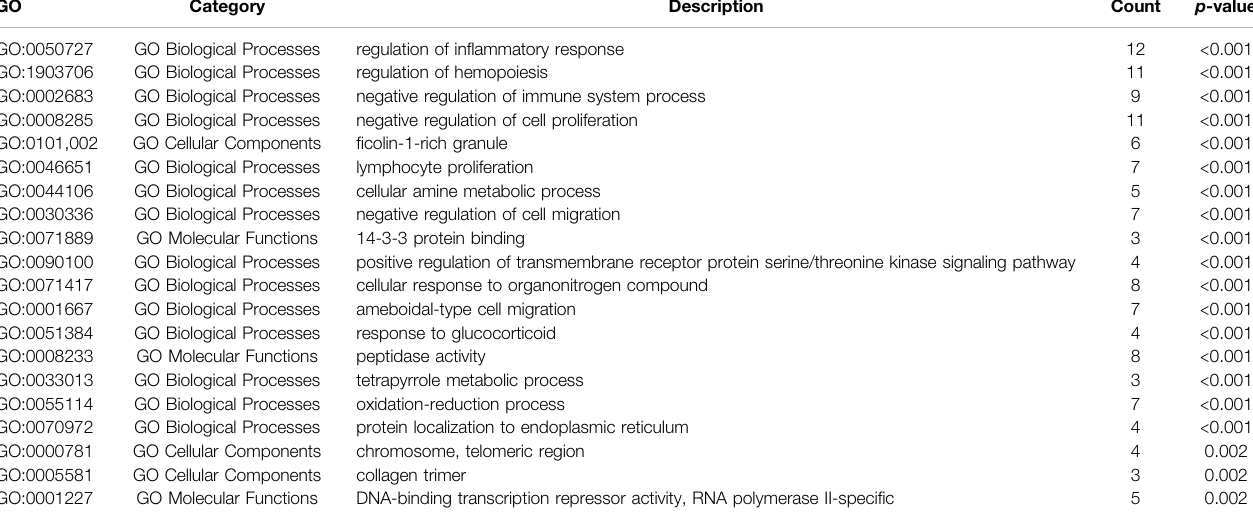
TABLE 1 | GO analysis of DEGs.